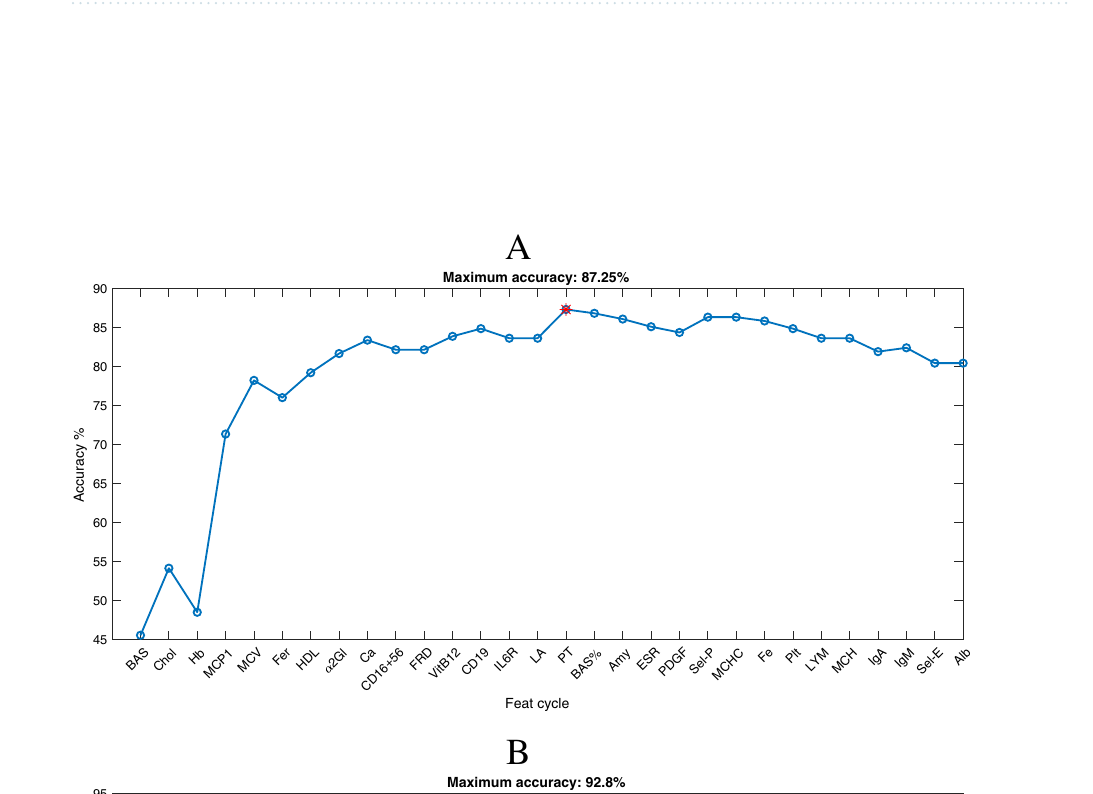
Table 4. List of significantly different blood analytes between high and low PR patients within the ALS and LMND groups.